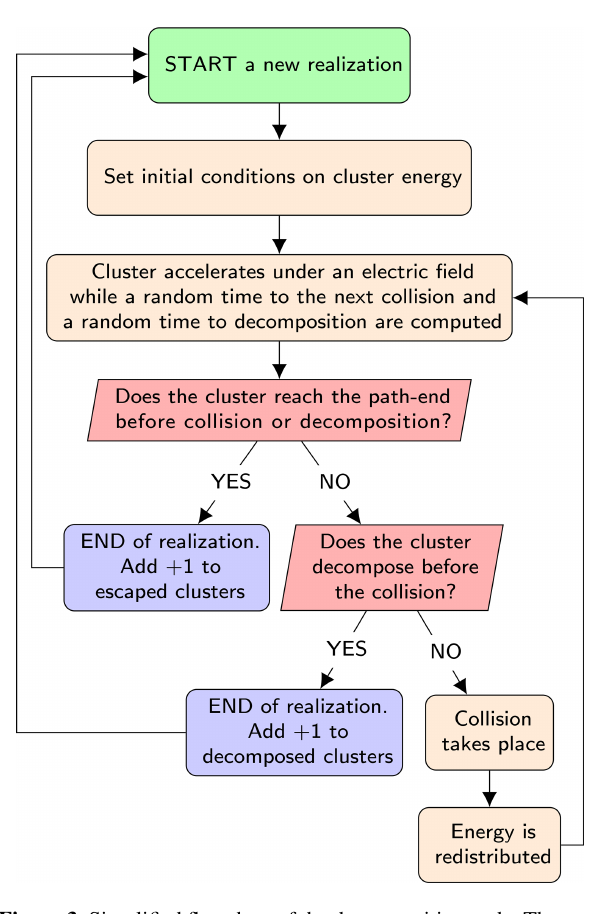
Figure 3. Simplified flowchart of the decomposition code. The pro- cess is repeated up to the required number of